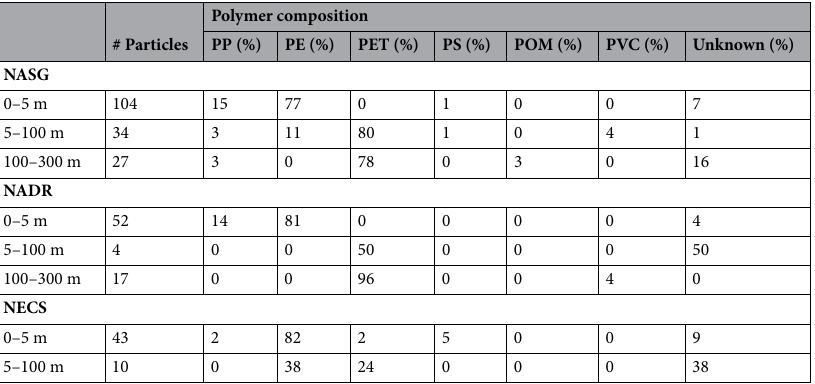
Table 2. Polymer composition of plastic particles collected by Manta trawling (0–5 m) and multinet underwater trawling (5–300 m). Note that while all particles from the multinet samples were analyzed, a subset of particles was analyzed from the Manta trawl samples. For the latter, if the number of particles per size class and type category exceeded 10 pieces, a random subset of 10 particles was analyzed. Raman spectra for which no reference could be allocated due to low spectra quality were labelled as “unknown”. NASG North Atlantic Subtropical Gyre, NADR North Atlantic Drift Region, NECS Northeast Atlantic Continental Shelves.